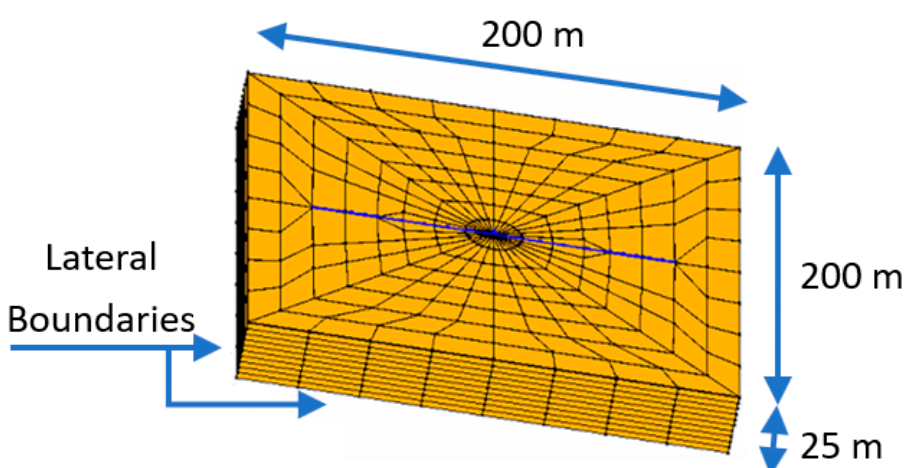
Figure 2. The finite element mesh (indications: dimensions and lateral boundaries).